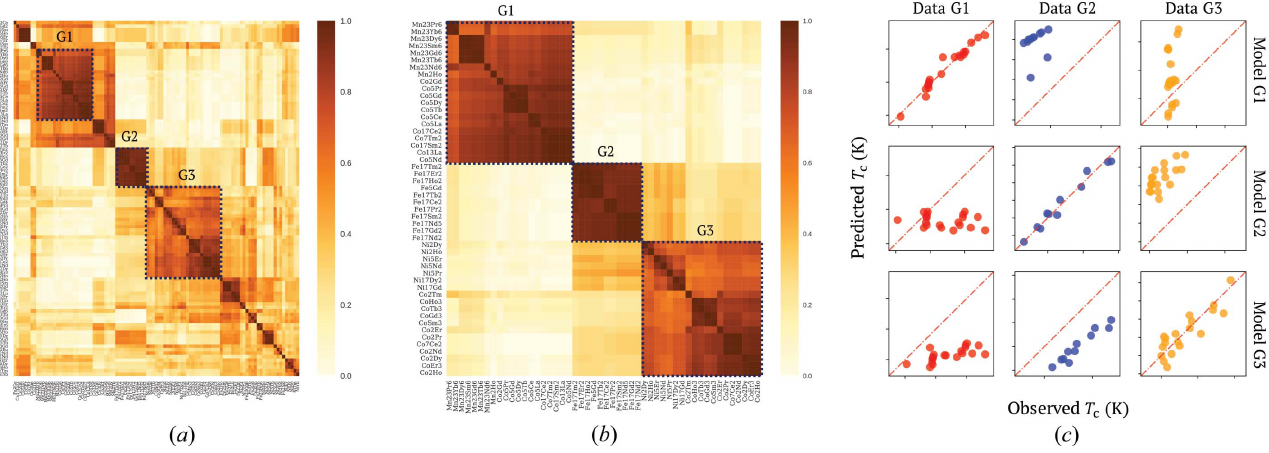
Figure 6 ( a ) The similarity matrix between the rare earth–transition metal alloys yielded by the regression-based committee voting machine. ( b ) Enlarged views of highly similar elements in the G1, G2 and G3 regions of the similarity matrix shown with dashed lines in panel ( a ). ( c ) Confusion matrices measuring linear similarities among alloys in each group as well as dissimilarities between models generated for alloys in different